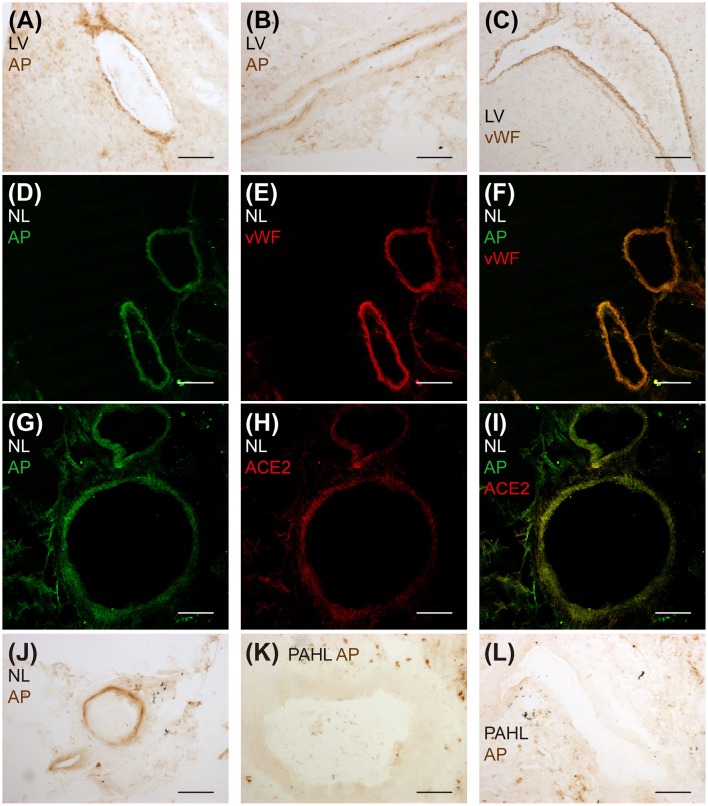
Detection of endogenous [Pyr1]apelin-13(1–12) peptide in human cardiovascular tissues. Bright field microphotographs of [Pyr1]apelin-13(1–12)-LI in (A) vascular and (B) endocardial endothelium and (C) vWF-LI in cardiomyopathy human heart. Confocal microphotographs of (D) [Pyr1]apelin-13(1–12)-LI (green), (E) vWF-LI (red) and (F) their overlay in normal human lung. (G) [Pyr1]apelin-13(1–12)-LI (green), (H) ACE2-LI (red) and (I) their overlay in normal human lung. Bright field microphotographs of (J) [Pyr1]apelin-13(1–12)-LI in normal human lung and (K,L) the absence of [Pyr1]apelin-13(1–12)-LI in PAH human lung tissue. LV, cardiomyopathy human heart; AP, [Pyr1]apelin-13(1–12); NL, normal human lung; PAHL, PAH human lung. Scale bar = 200 μm.